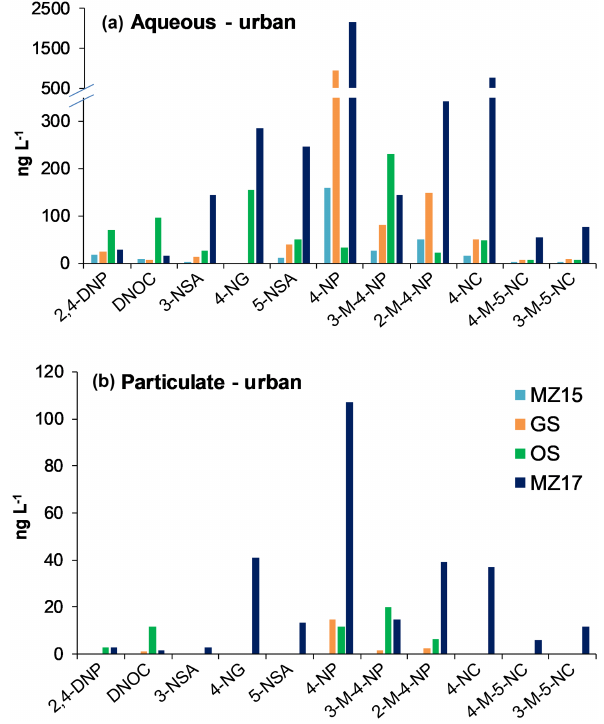
Figure 4. NMAHs in urban snow